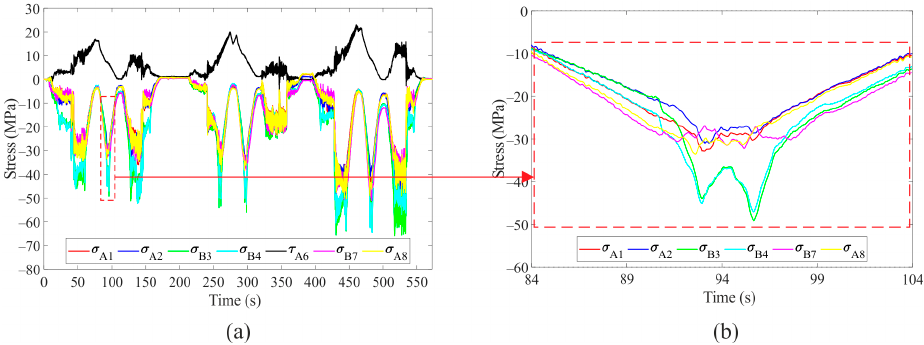
Figure 4. Time courses of stresses, Mode 2; manipulation of coils 1, 2 and 3: ( a ) full record, ( b ) detail record for the crab passing through the center of the girders.